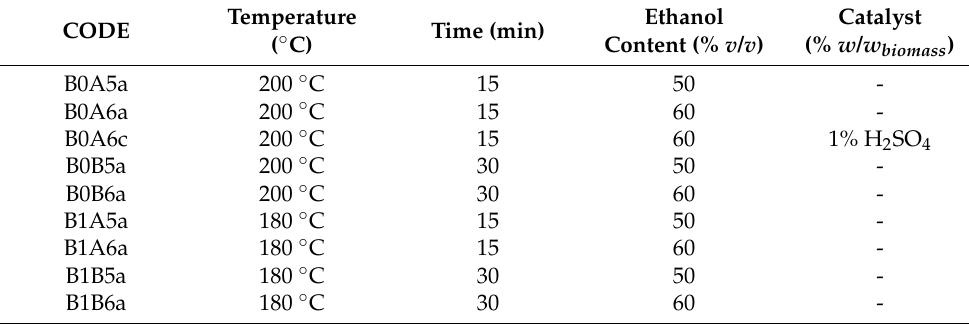
Table 3. Experimental conditions during organosolv